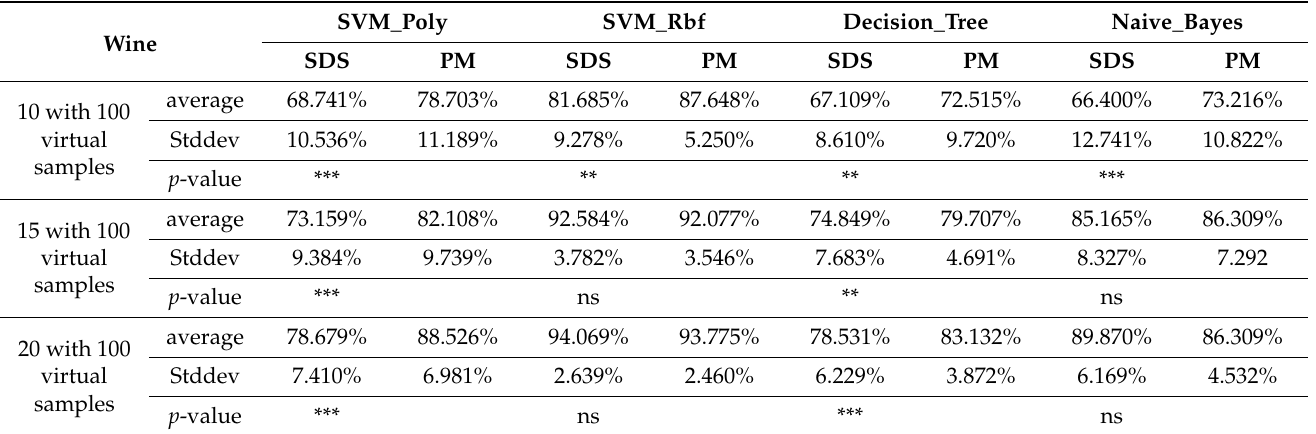
Table 3. The result of generating 100 virtual samples by WGAN_MTD for the Wine dataset.